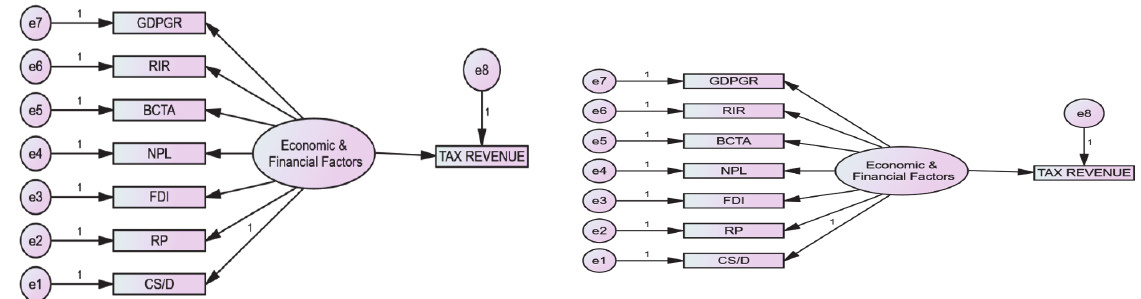
Fig. 1. The proposed